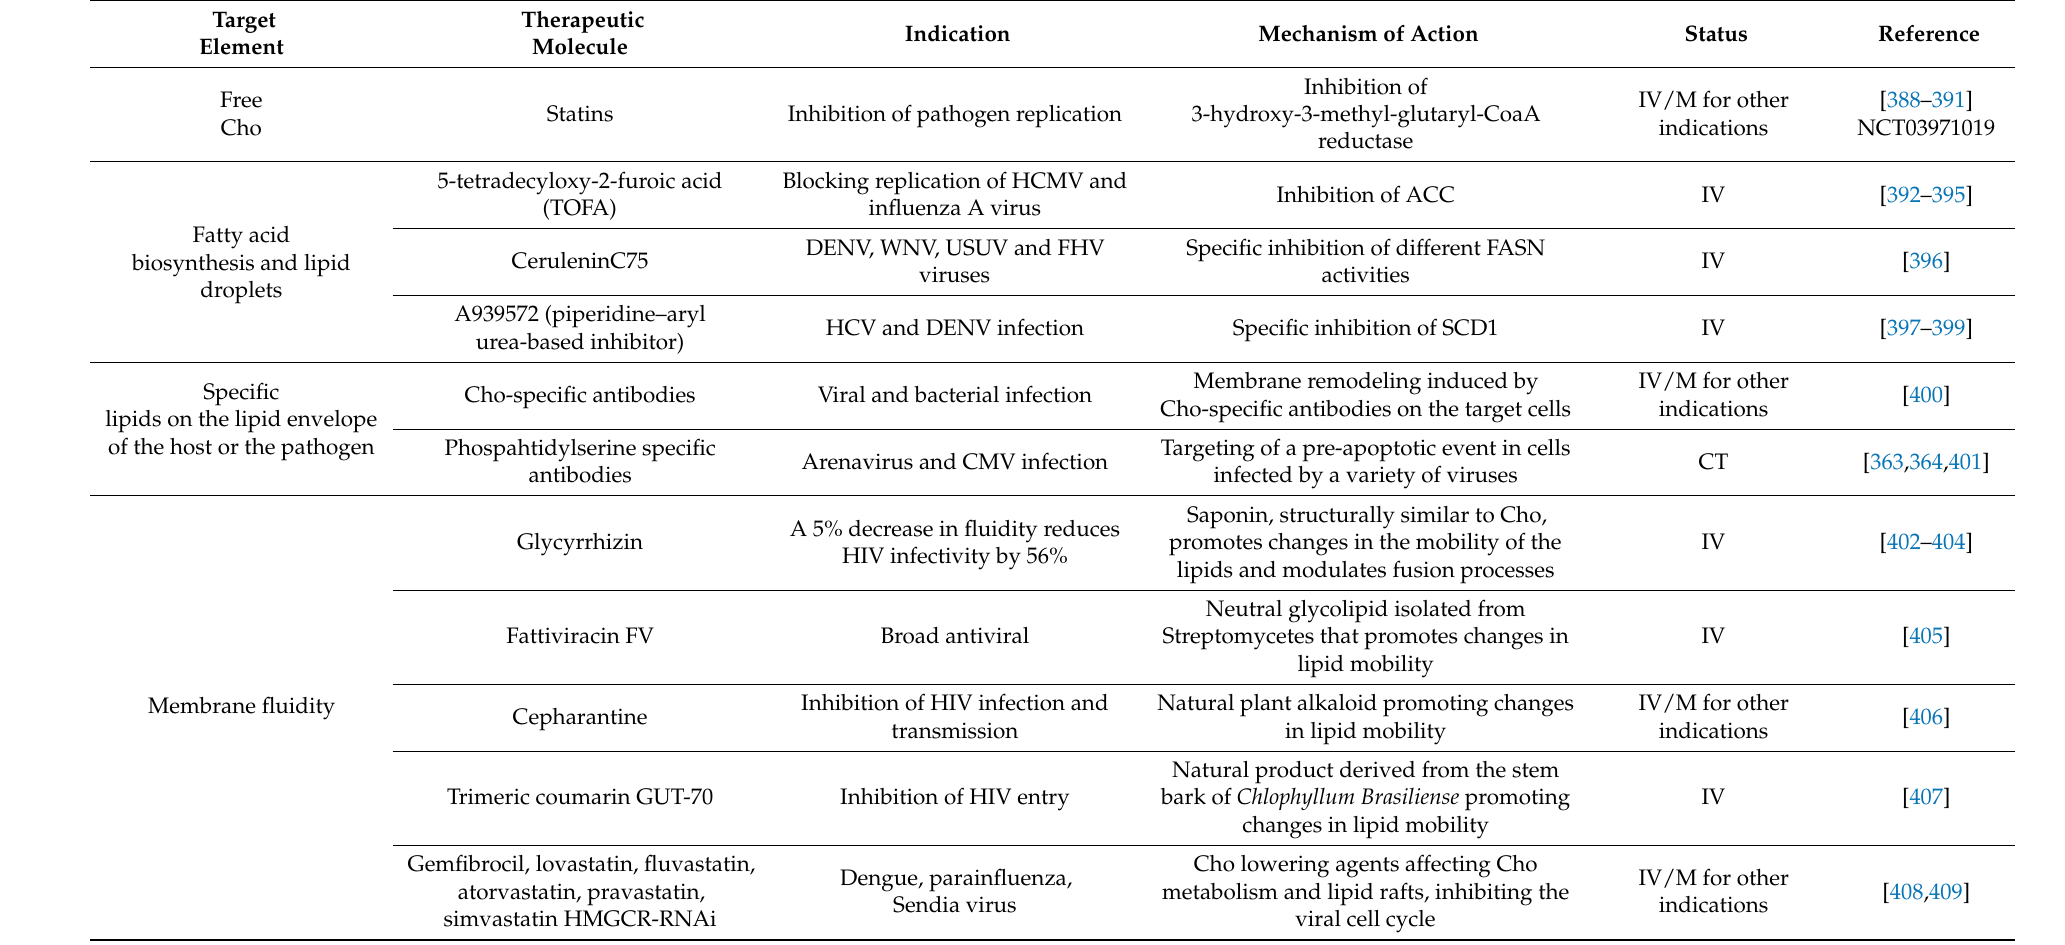
Table 1. Lipid-targeting therapeutic approaches in infectious